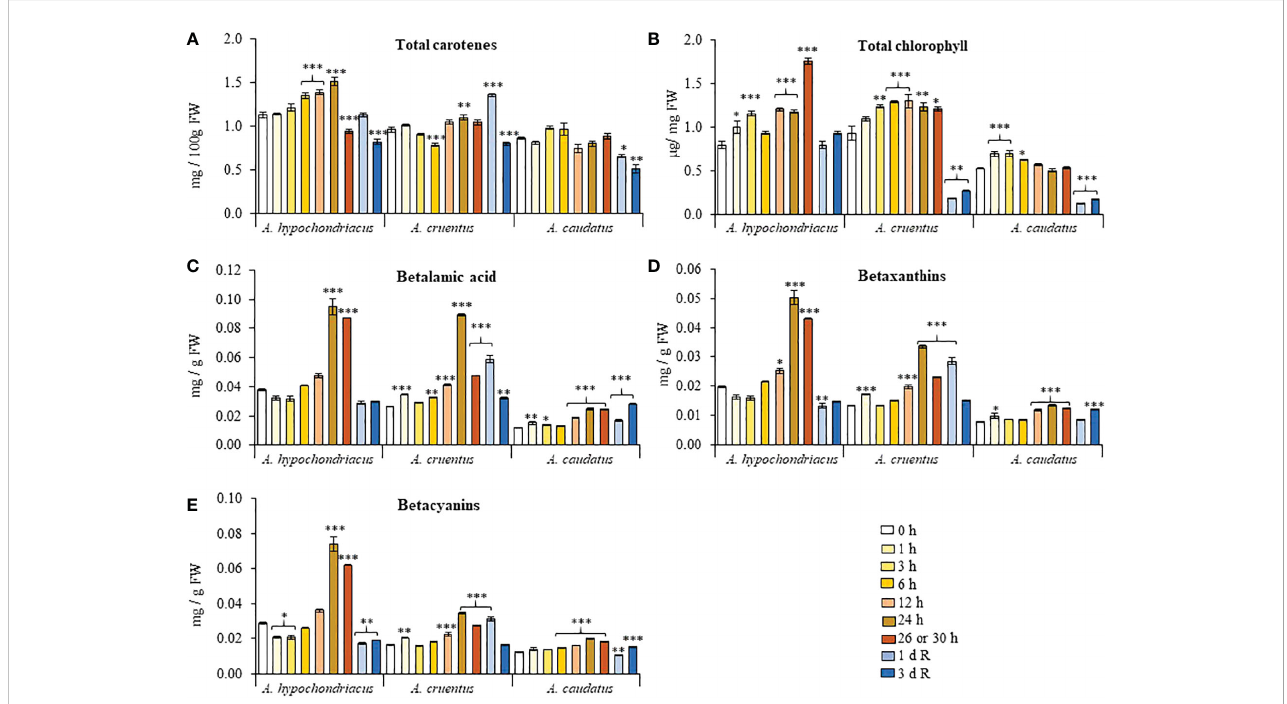
FIGURE 4 Fluctuation in the levels of different pigments recorded during heat shock and subsequent recovery in grain amaranth plants. Changes in the levels of (A) total carotenes, (B) total chlorophyll, (C) betalamic acid, (D) betaxanthins and (E) betacyanins detected in leaves sampled from grain amaranth plants at the V1 development stage subjected to heat shock (HS) for 0, 1,3, 6, 12, 24, 26 ( Amaranthus cruentus ) or 30 h ( A. hypochondriacus and A caudatus ) and after 1 (1 d R) and 3 (3 d R) days of recovery from HS under optimal conditions. The bars represent the mean value (n = 30) ± SE. Asterisks over the bars represent statistically signi fi cant differences within species at P ≤ 0.05 (*), P ≤ 0.01 (**) or P ≤ 0.001 (***); one-way ANOVA and Tukey Kramer